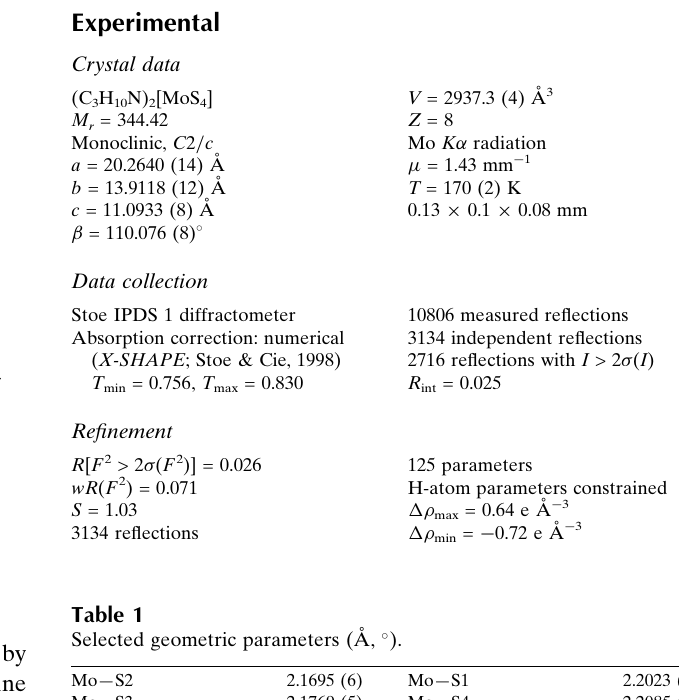
Data collection Stoe IPDS 1 diffractometer Absorption correction: numerical